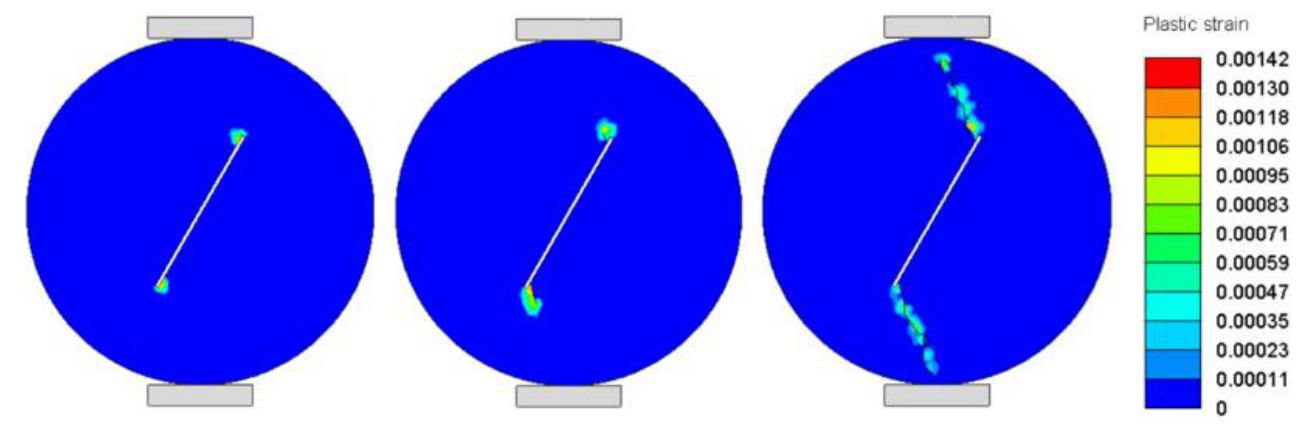
Figure 19. Plastic strain evolution for Brazilian disc with a crack of 30° angle.